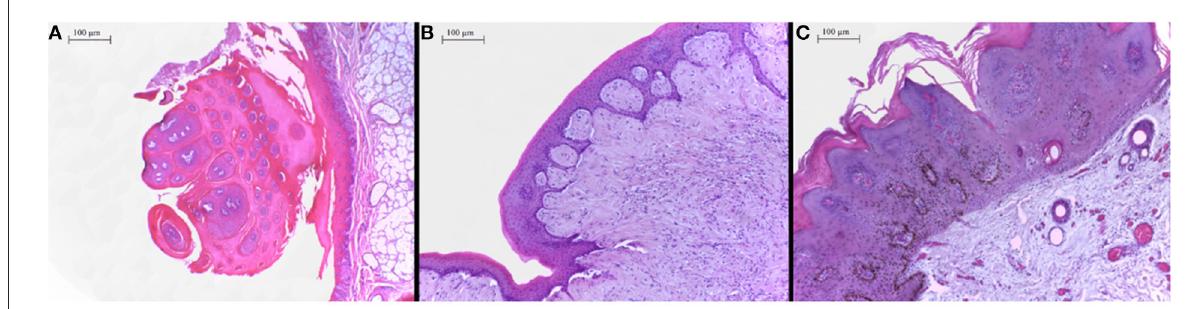
FIGURE2 (A) Proximal esophagus, exophytic proliferation of papillary projections of stratified squamous epithelium forming thick fronds supported by a thin core of fibrovascular stroma converging to a common peduncle. Hematoxylin-eosin (HE) 4 × . (B) Ruminal fibropapilloma with neoplastic proliferation of squamous epithelial cells and mesenchymal cells forming streams, expanding the submucosa and elevating the overlying proliferated mucosa. The epithelial component forms numerous acanthomatous projections into the mesenchymal component. Hematoxylin-eosin (HE) 10 × . (C) Skin, face, a thick proliferation of squamous epithelial cells is seen forming a broad-based well-delimited nodule with moderate